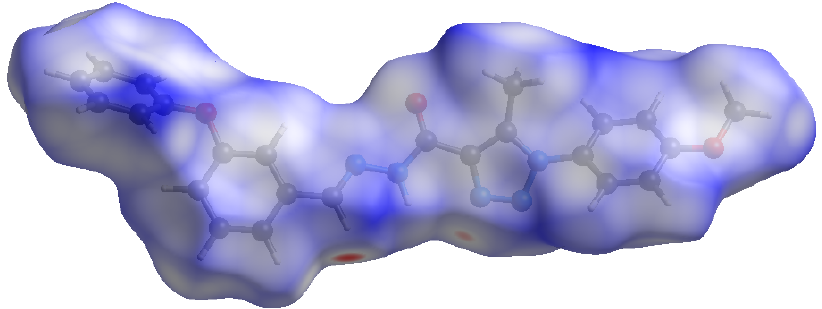
Figure 5. The Hirshfeld surface of a molecule of 2 mapped with d norm . There are five red spots on the d norm surface. These spots are indicators of short contacts such as hydrogen bonding interactions. The spots are on the O1, O2, N3, H13, and H17C atoms (Figure 5) and are consistent with the intermolecular interactions given in Table 1. The fingerprint plots (2D representation of a Hirshfeld surface) with percentages for the elements involved in the contacts are presented in Figure 6b. The major interactions are H···H/H···H (44.4%), C···H/H···C (22.3%), N···H/H···N (12.7%), O···H/H···O (11.8%),